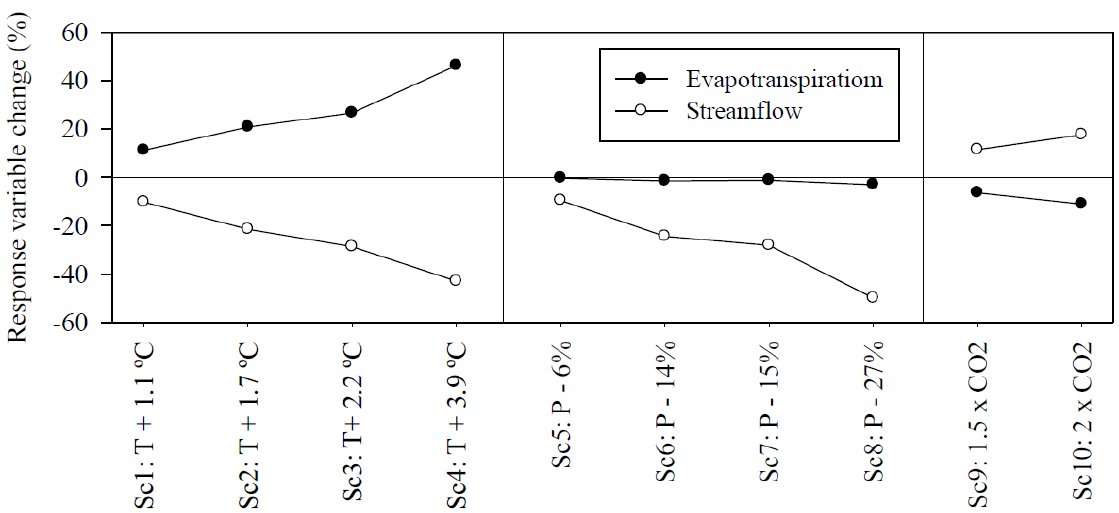
Figure 4. Response of evapotranspiration and streamflow to changes in temperature, rainfall and CO 2 concentration based on the scenarios defined in Table